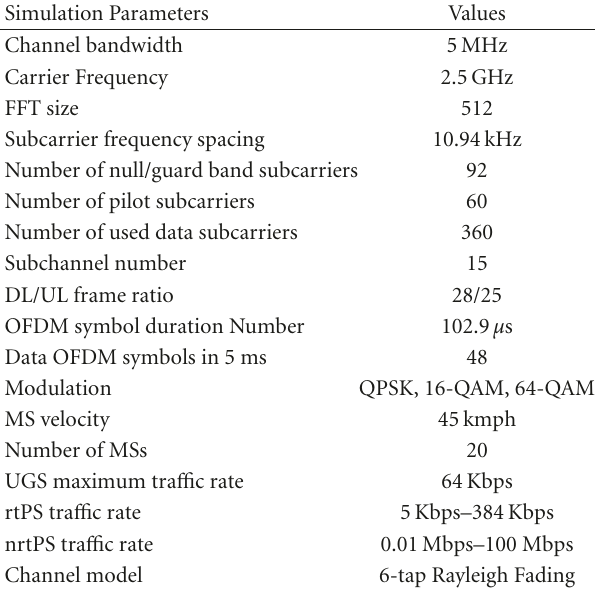
Table 1: Simulation